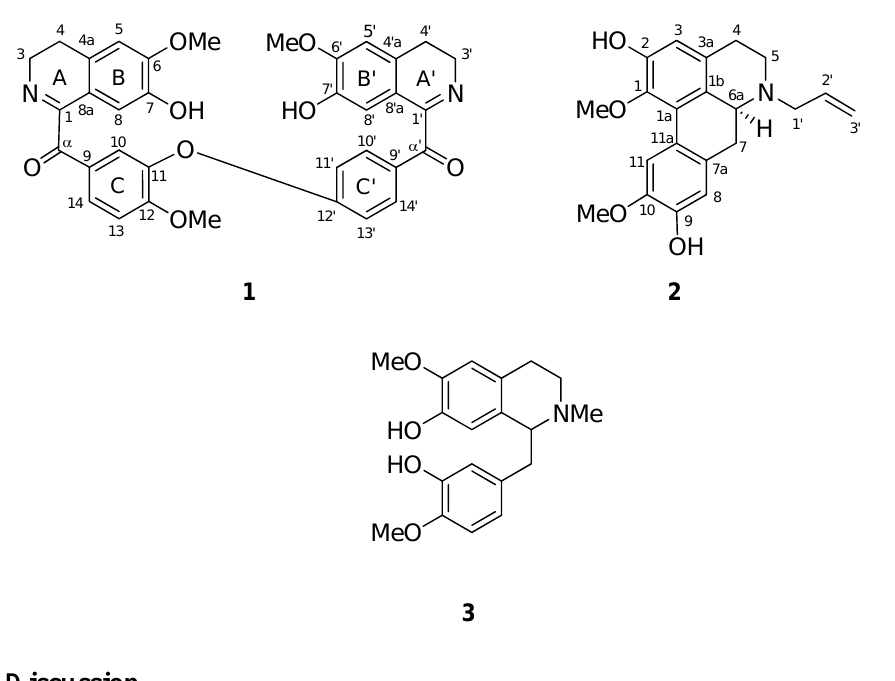
Figure 1. Structures of lancifoliaine ( 1 ), N -allyllaurolitsine ( 2 ) and reticuline ( 3